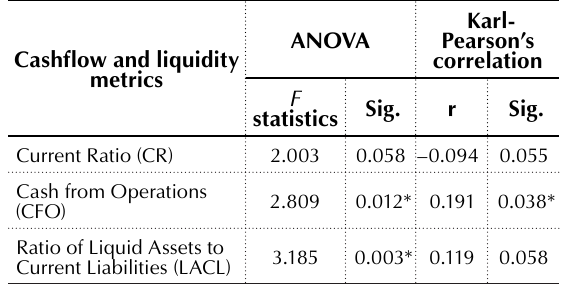
Table 6. Results of ANOVA and Correlation